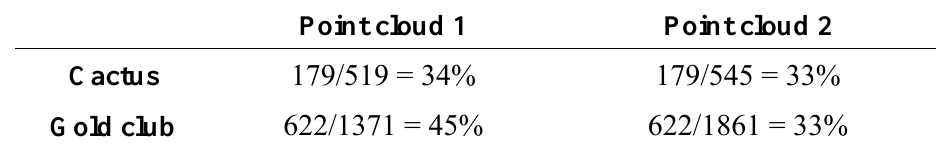
Table 2. Sizes of the overlapping regions are represented as percentages of the whole point cloud, i.e. the denominator is the total number of points in the point cloud and the numerator is the number of points in the overlapping